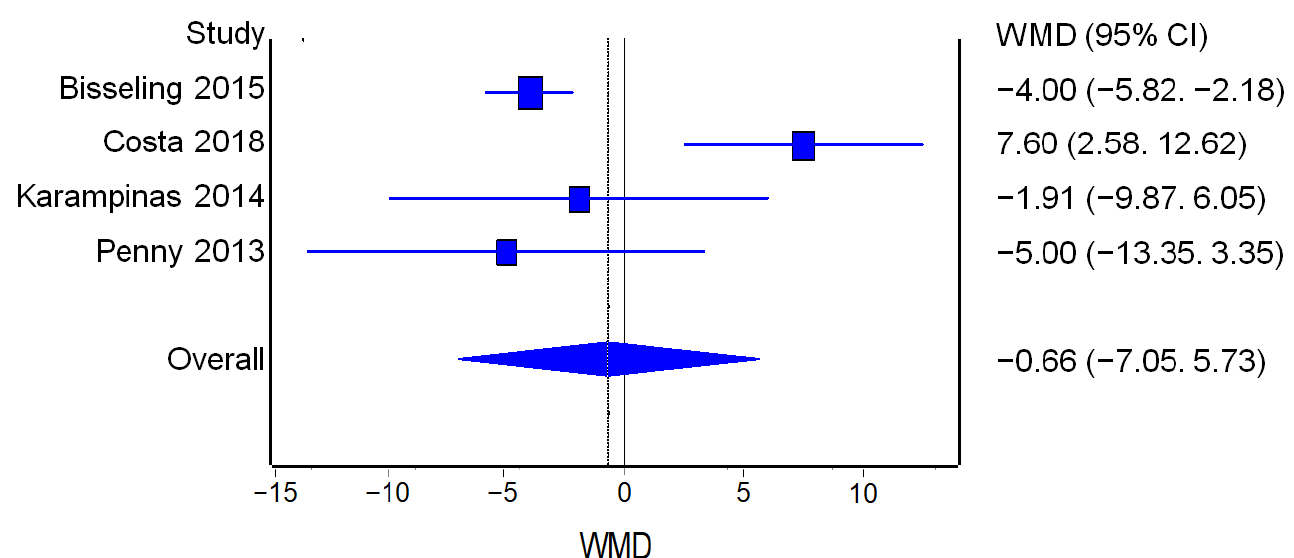
Figure 10. HHS: Forest plot of the individual studies and pooled mean difference for HHS im-